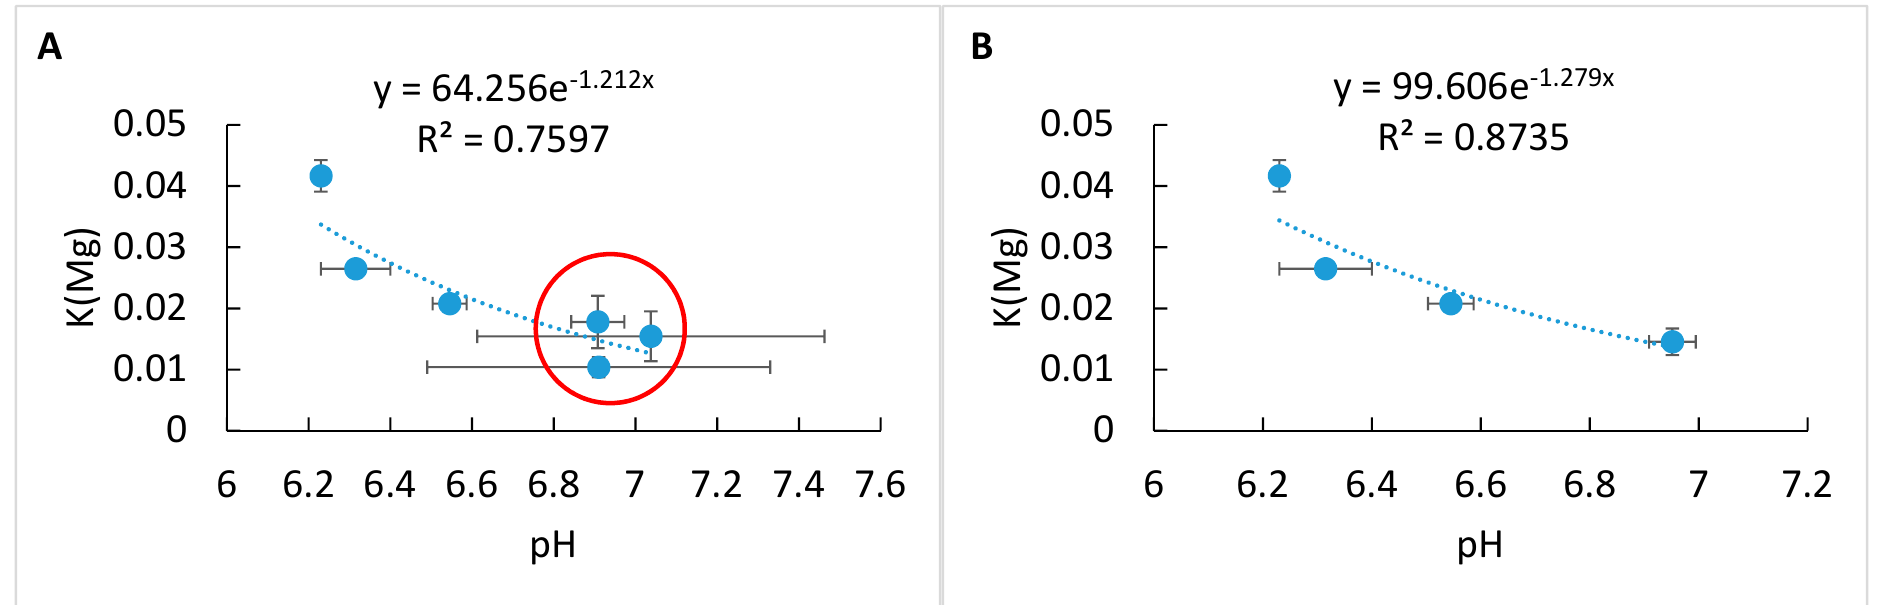
Figure 8. ( A ) A plot of K Mg versus pH for the experiments run at low aqueous Mg/Ca (0.02 < Mg/Ca < 0.05 mol/mol). ( B ) The averaging of the three data points with overlapped pH values due to the high error bars (red circle seen in A) yielded a better fit with r 2 = 0.82